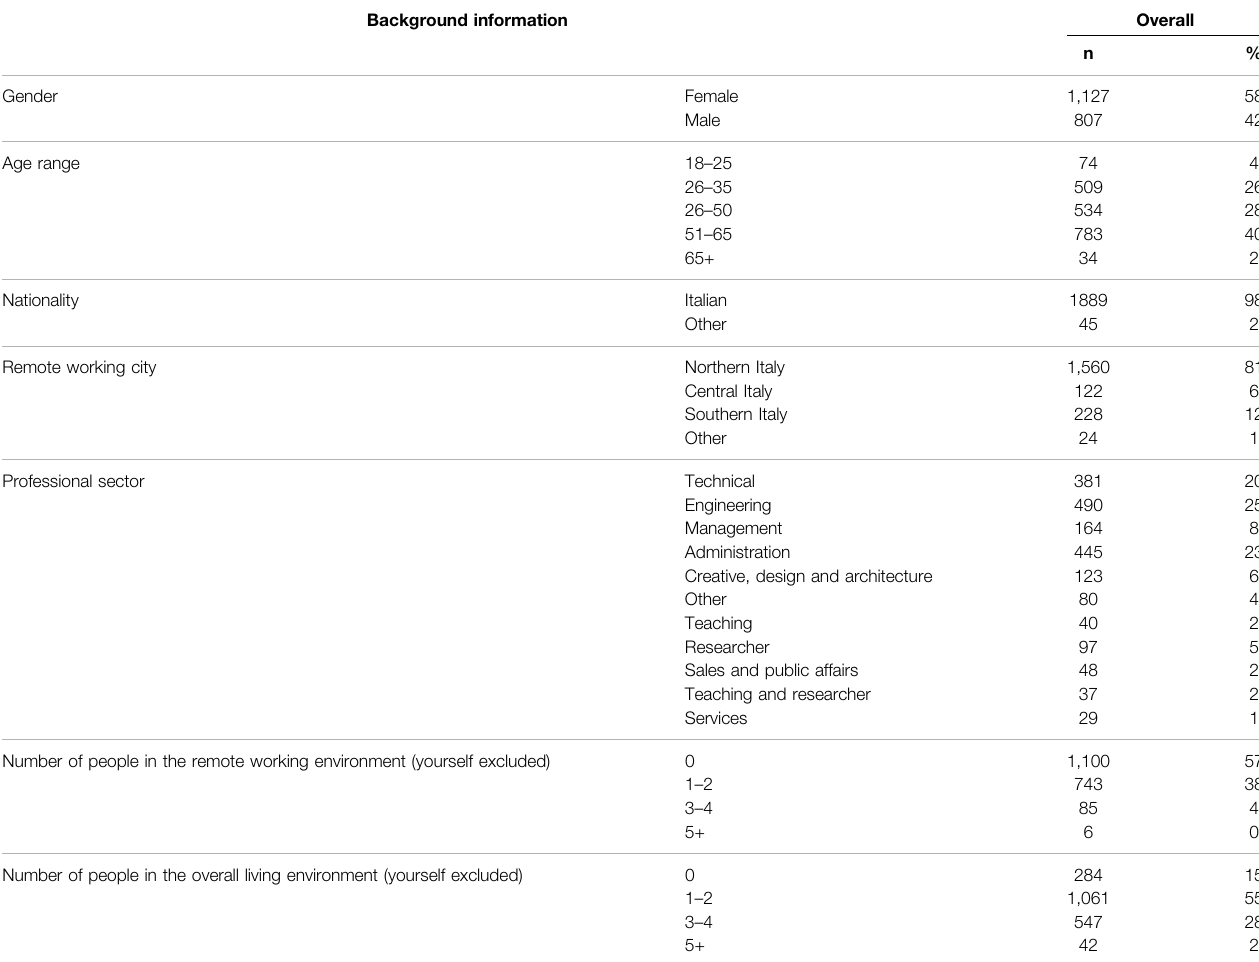
TABLE 1 | Main characteristics of the total sample ( n (cid:1) 1934) given